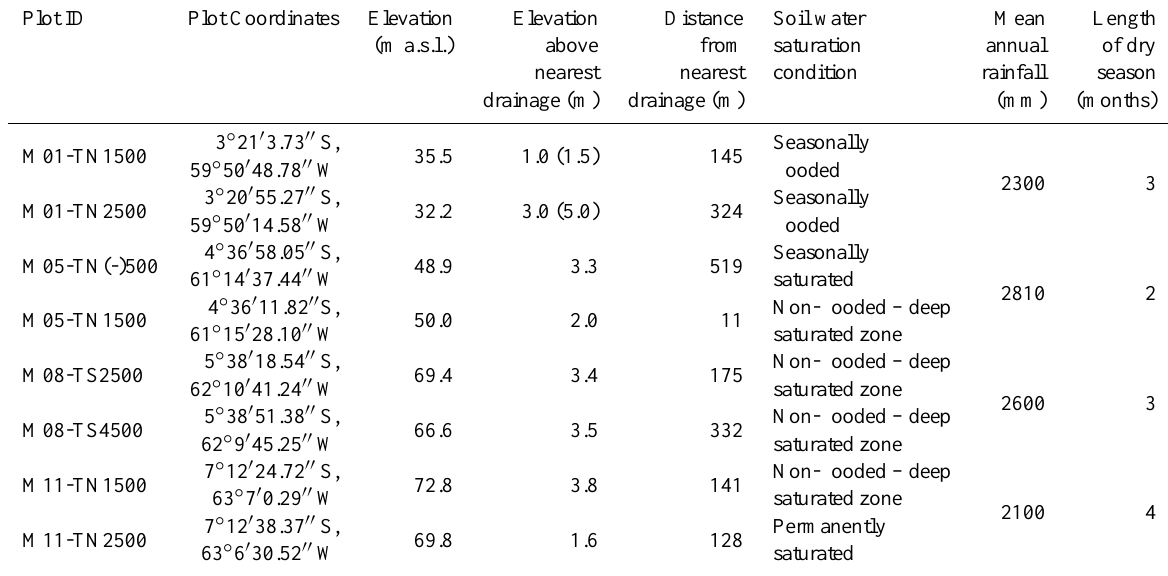
Table 1. Geographical position, hydrology and rainfall patterns of the selected study sites. Elevation above sea level (a.s.l.) is estimated by SRTM data (Shuttle Radar Topographic Mission). Data of the HAND model (Height Above Nearest Drainage) indicate the distance and elevation above the nearest drainage (Rennó et al., 2008); number in parenthesis indicates the flood height of seasonally inundated forests measured in the field. Soil water saturation conditions are described and presented in more detail in Table 2. Rainfall data were obtained from the Brazilian Water Agency (Agência Nacional de Águas – ANA). Length of dry season refers to number of months with less than 100mm of rainfall. Plot ID Plot Coordinates Elevation